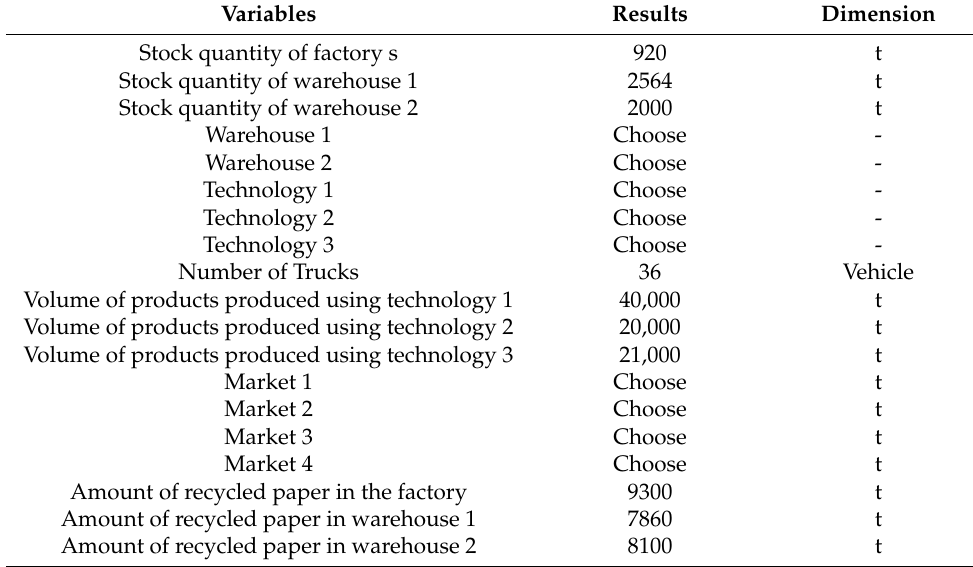
Table 8. Main results solved by the model.